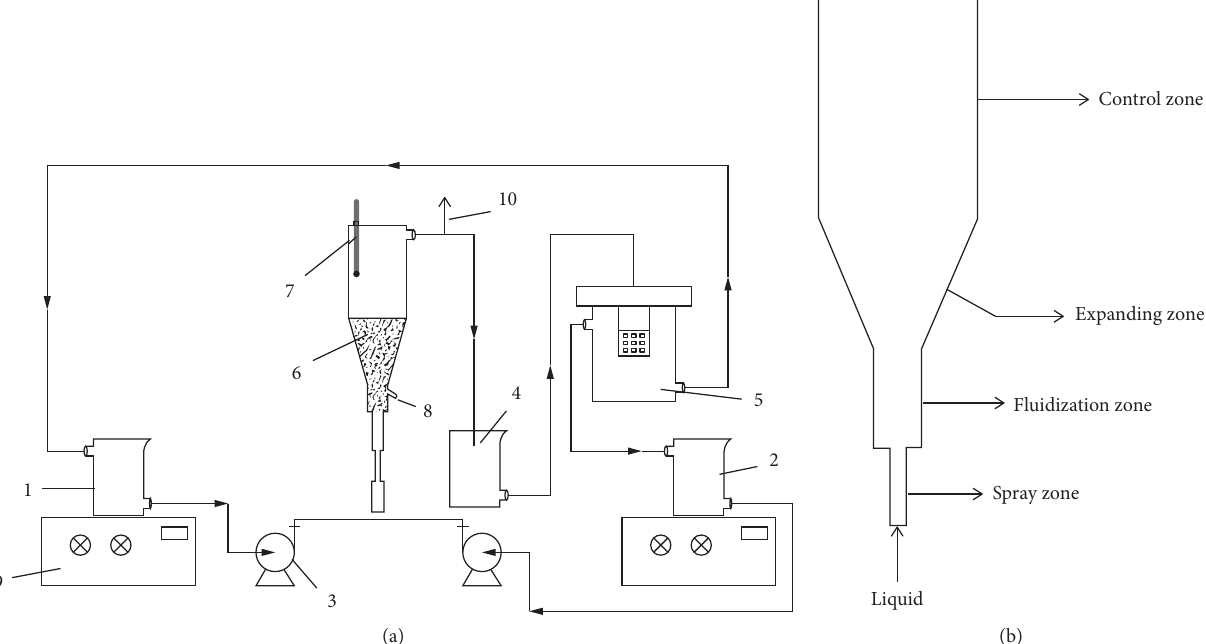
Figure 3: (a) The schematic diagram of the experimental setup; (b) the structure chart of the spray fluidized bed crystallizer. 1, aqueous phase feed; 2, oil phase feed; 3, recirculation pump; 4, buffer tank; 5, phase-separation tank; 6, crystallizer; 7, temperature probe; 8, reclaiming port; 9, thermostatic water bath; 10,